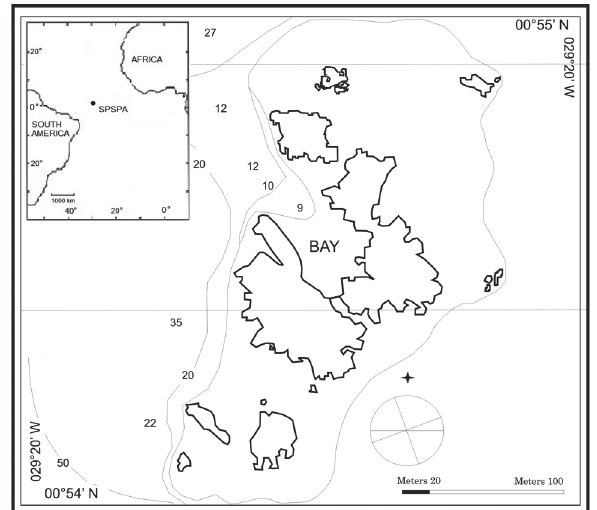
Fig. 1. Geographical location and map of the São Pedro e São Paulo